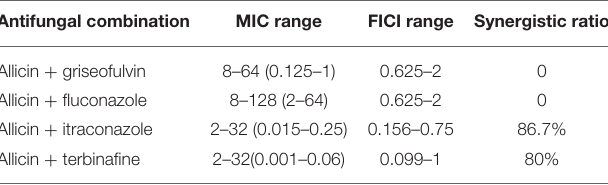
TABLE 3 | MIC ranges of drug combinations, FICI ranges and synergistic ratios of tested M. canis strains ( µ g/mL). Antifungal